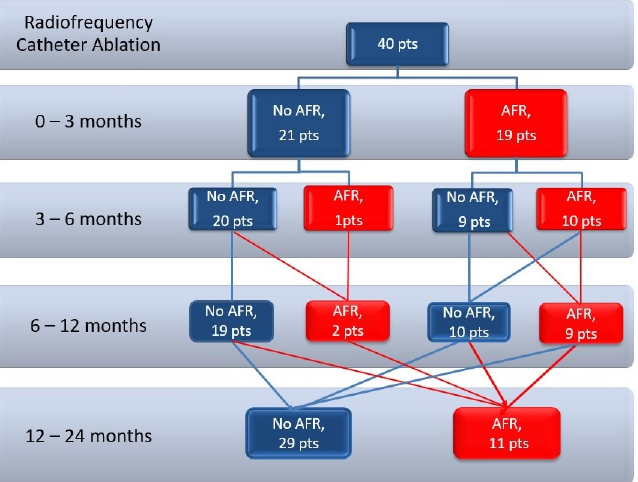
Figure 1. Patients flow chart—outcome after AF ablation. Pts = patients; AF = atrial fibrillation; AFR = atrial fibrillation recurrence.